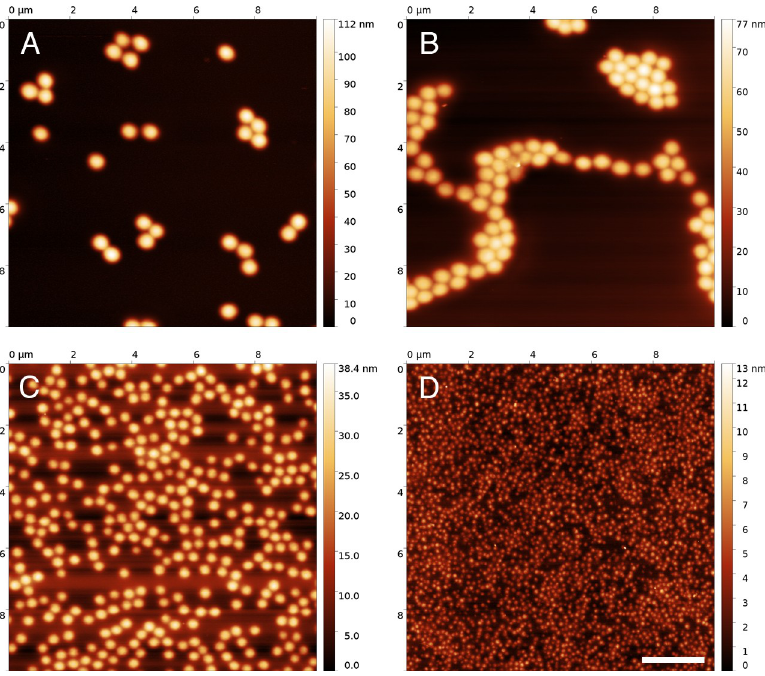
Fig 1. Analysis of microgel physical and chemical properties. (A-D) Atomic force microscopy images showing microgels generated using 5mol% cross-linker (A) or 0% (B), 0.5% (C) or 2.5% (D) CTAB. The legend on the side of each atomic force microscopy image indicates the height of the arrays. Scale bar: 2 μ